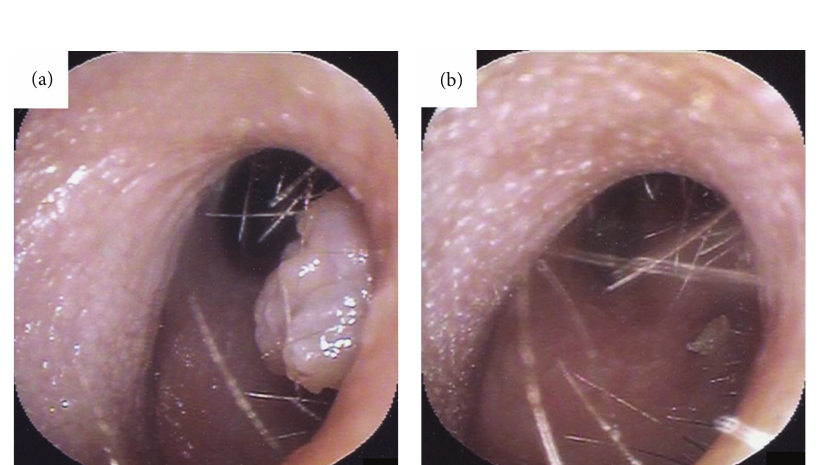
Figure 1: Endoscopic photographs of the left external auditory canal. (a) Fibroepithelial polyp at the posterior wall of the inlet of the left external auditory canal. (b) Left external auditory canal 1 week after resection of the fibroepithelial polyp.